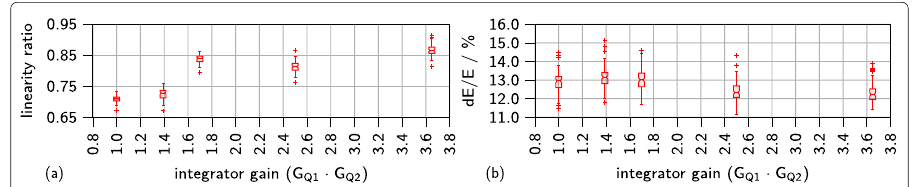
Fig. 10 Energy linearity and energy resolution for different integrator gain configurations. The default configuration is G Q1 · G Q2 = 1.0. a Energy linearity computed as the ratio of the 511 keV and 1274.5 keV peak positions in the energy value histogram. b Energy resolution (dE/E) computed using the FWHM of the 511 keV peak in the energy